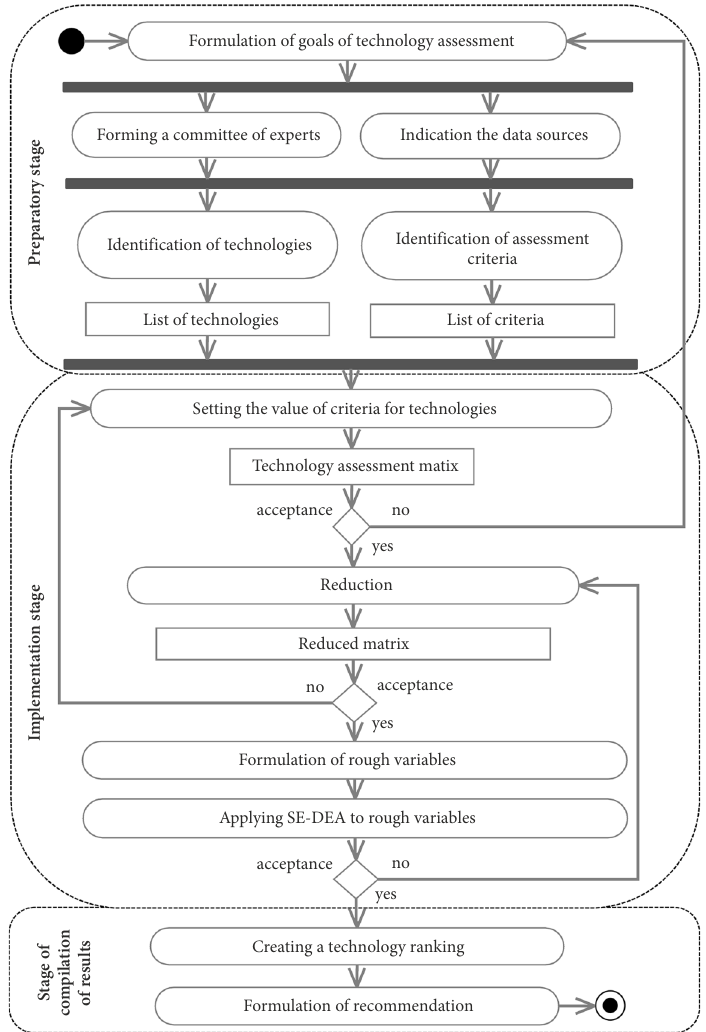
Figure 3. Diagram of the technology prioritisation process using a hybrid